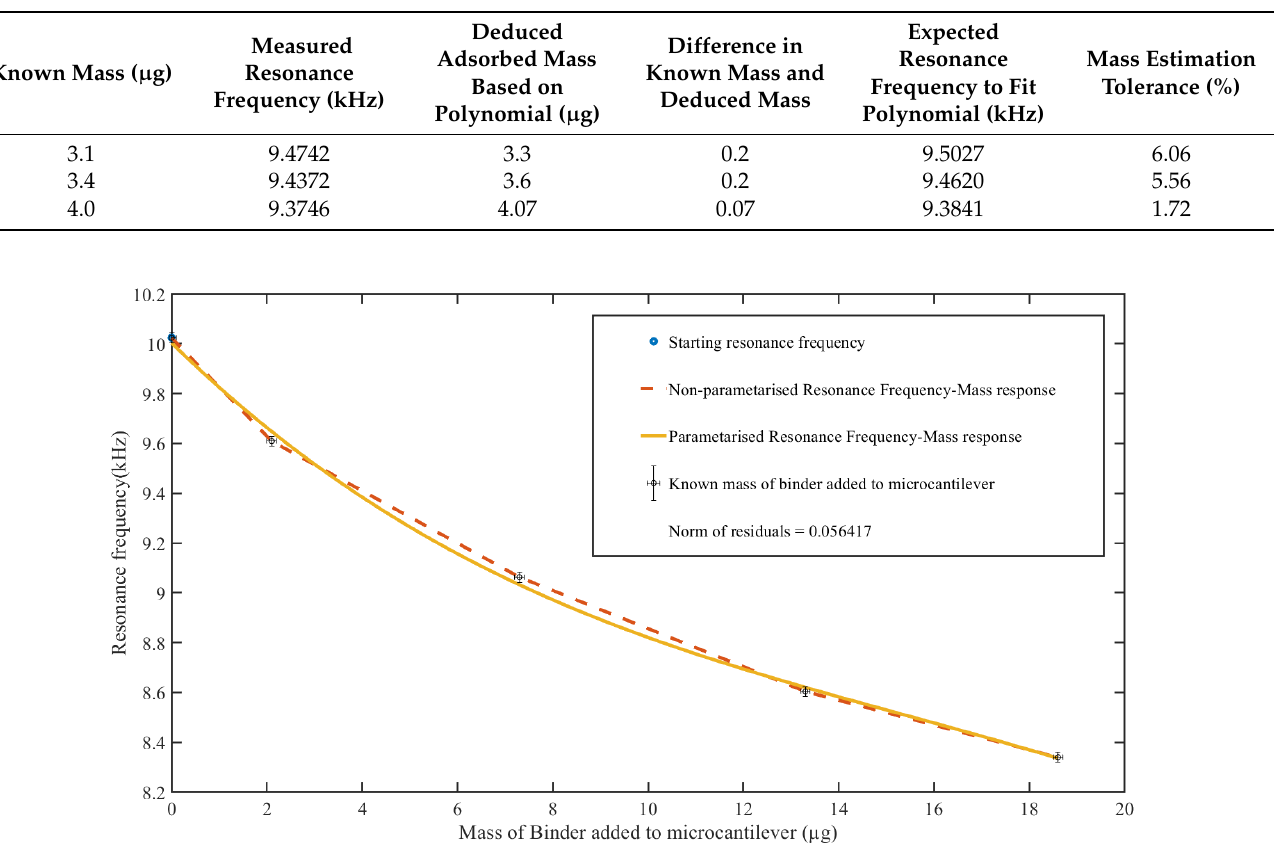
Table 4. Response of the second set calibration polynomials based on the binder solution with test masses of the binder solution.